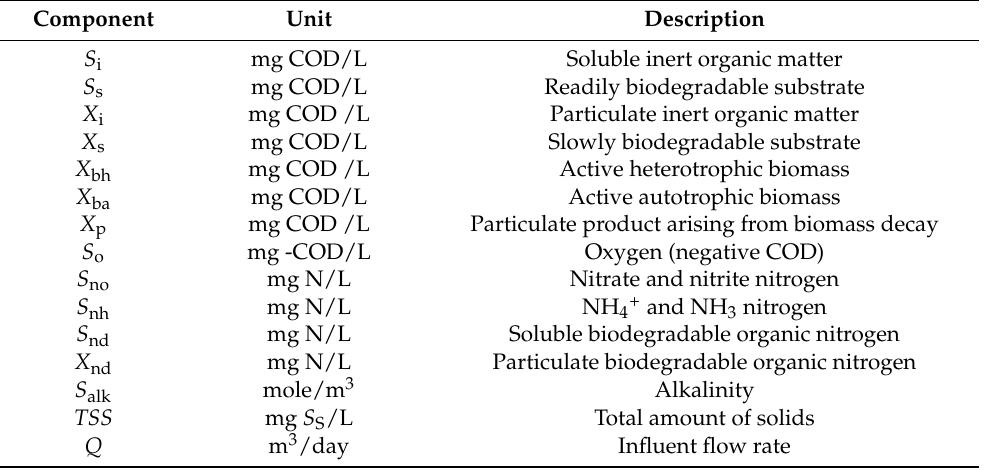
Table 2. Components of wastewater. COD: chemical oxygen